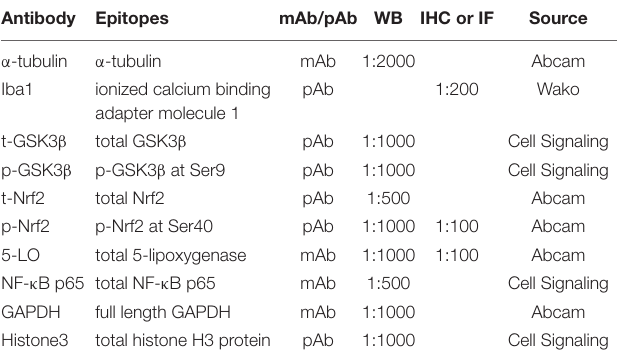
TABLE 1 | Antibodies used in this study. Antibody Epitopes mAb/pAb WB IHC or